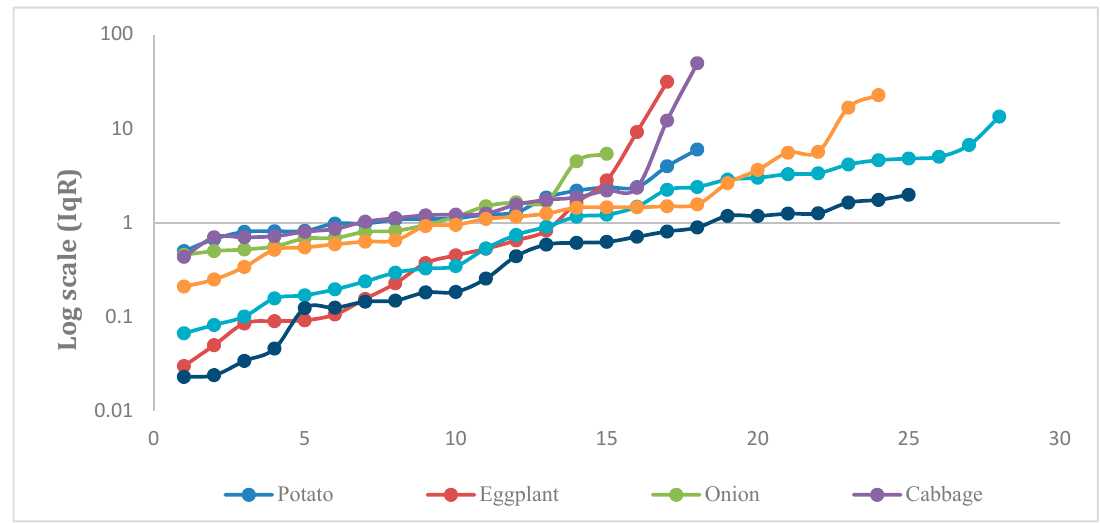
Figure 4. The calculated quality index for residue (IqR) for the selected vegetable commodities on a Log scale. Table 5. The quality of the selected vegetables according to the calculated IqR.